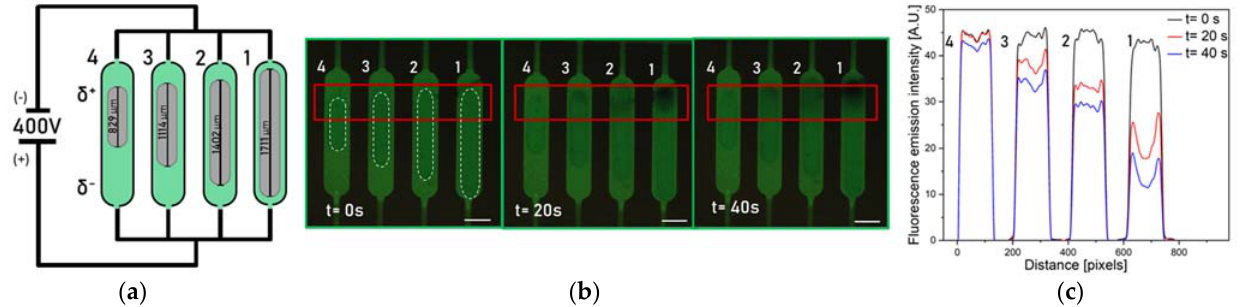
Figure 4. ( a ) Schematic (not to scale) of the experiments performed using the Pt electrodes in the chambers simultaneously. ( b ) Fluorescence images showing the activity of BPEs used simultaneously upon the application of an external driving potential E tot = 400 V. ( c ) Fluorescence emission intensity profile at the anodic poles of the electrodes. The change in fluorescence intensity reflects the decrease in the pH of the solution, due to the O 2 production via water splitting. The available overpotential for O 2 production is proportional to the length of the electrodes. Scale bars: 350 μ m.